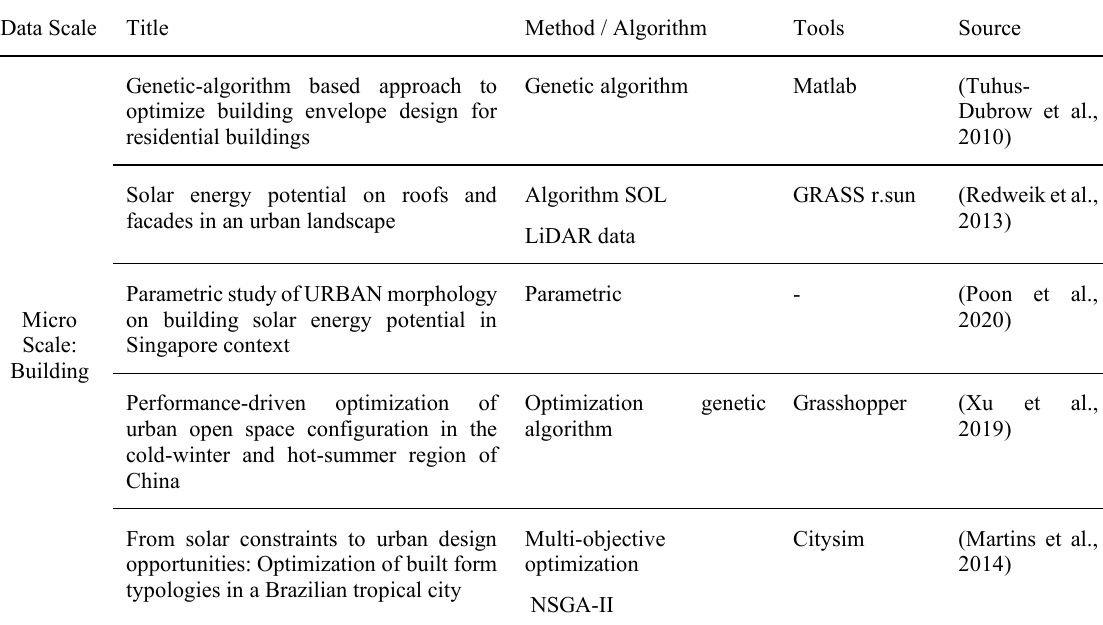
Table 1. Studies on urban structure and solar energy